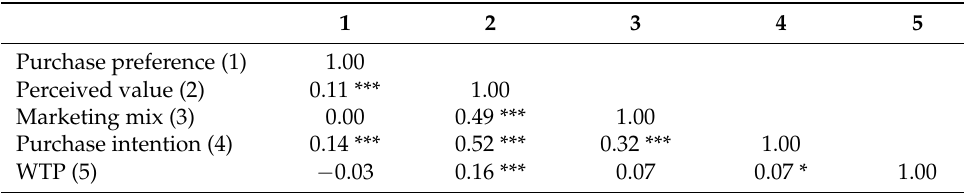
Table 2. Pearson’s correlation among the variables ( n =